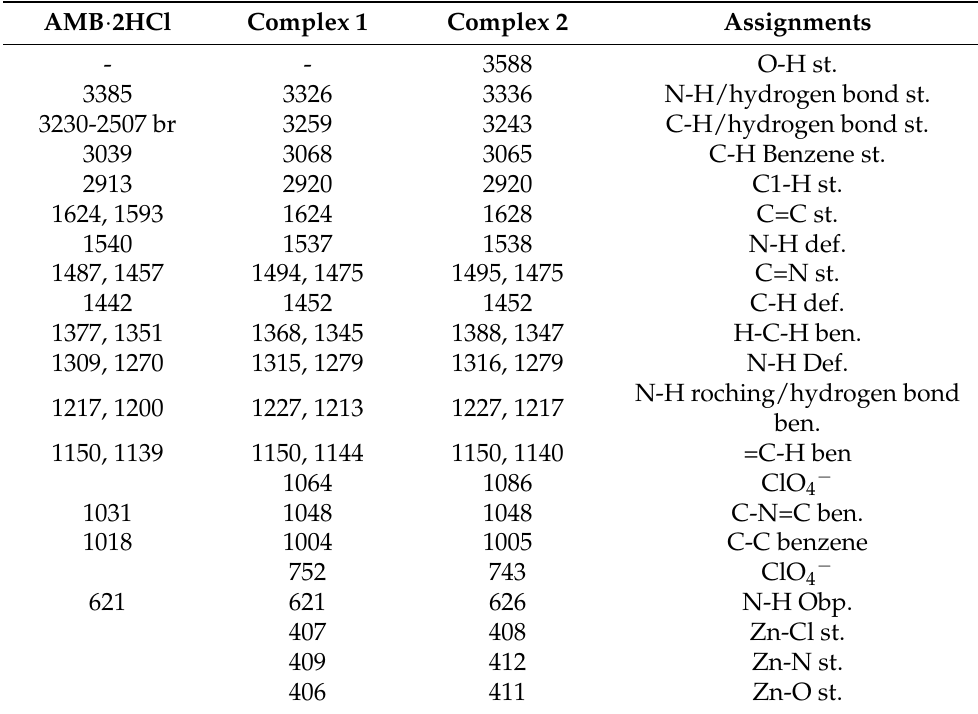
Table 1. IR assignments of the ligand AMB · 2HCl and its zinc(II) complexes 1 and 2